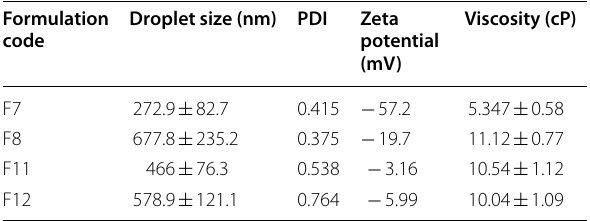
Table 4 Droplet size, PDI, zeta potential, and viscosity of SMEDDS formulations